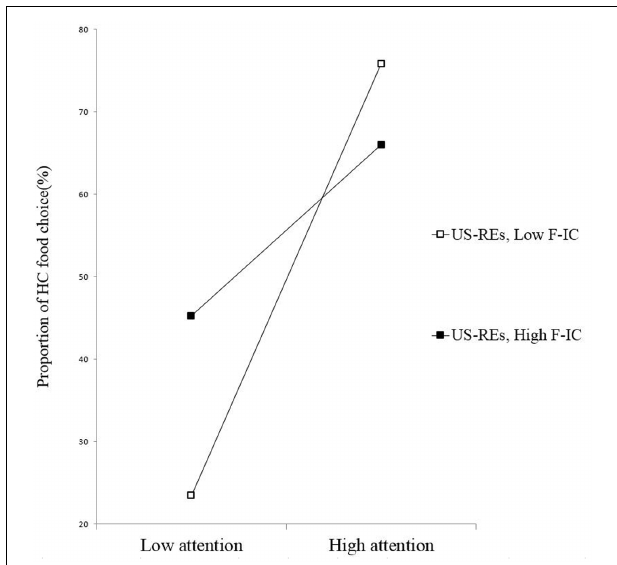
FIGURE 3 | Slopes for the automatic attention–food choice relationship across levels of F-IC among the US-REs.